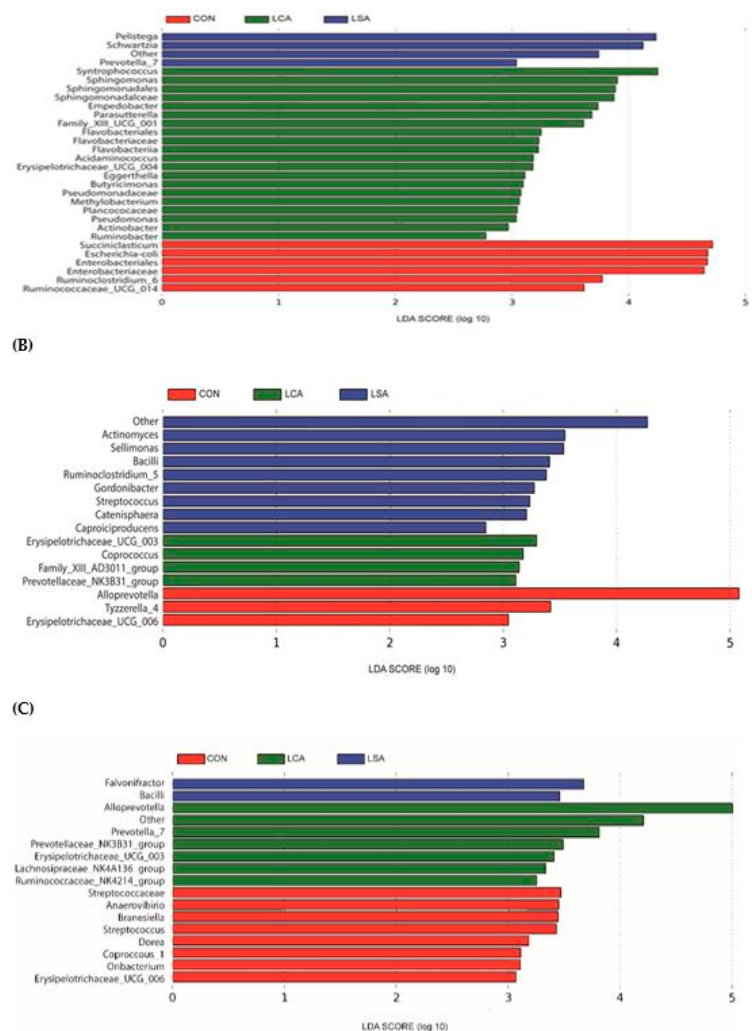
Figure 5. Linear discriminant analysis (LDA) for the significantly abundant microbes across treatments in the ileum, colon and rectum. Histogram of the LDA scores calculated for differentially abundant genera in the ileum, colon and rectum at the genus level among the different treatments groups (only the genera LDA scores above 2 are shown). A = ileum; B = colon and C = rectum. CON = control; LCA = low cocktail of antibiotics concentration; LSA = low concentration of single antibiotic.